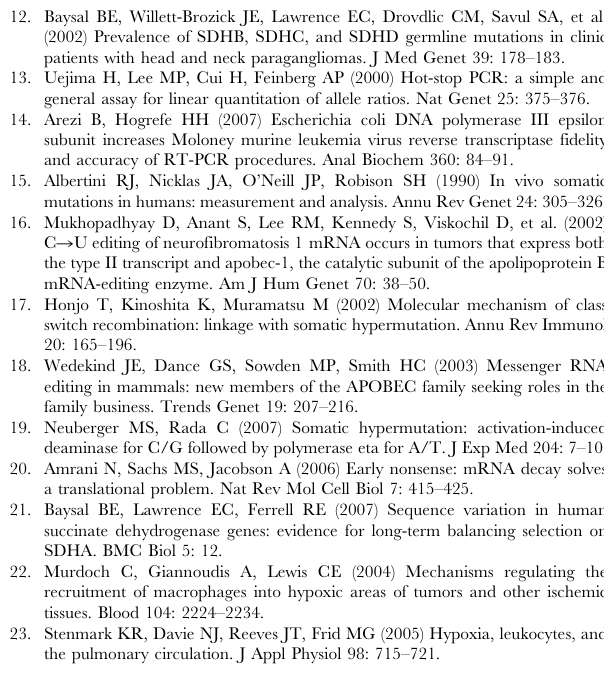
Table S2 Transcript mutations in SDH subunit genes. *1 misincorporation per 13,263 bp on the basis of